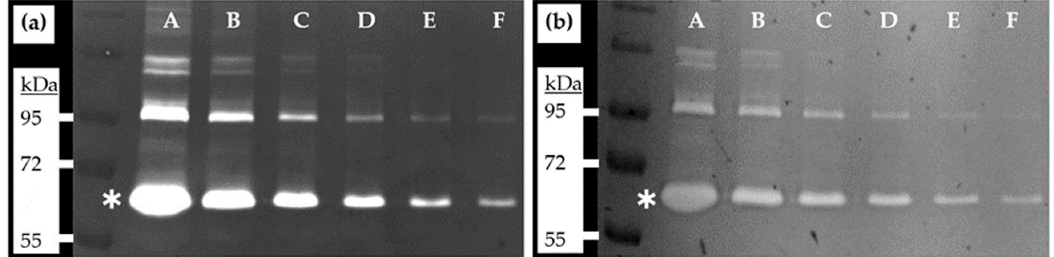
Figure 1. Zymography gels showing bands generated by gelatinolytic activities present in fetal bovine serum samples. ( a ) Coomassie staining; ( b ) Ponceau staining. For sample description (FBS equivalents), see Table 1. Asterisks mark the position of active MMP-2 enzymatic activity with a molecular weight of 62 kDa. Exemplary bands of the color prestained protein standard (New England Biolabs, # P7719G) are